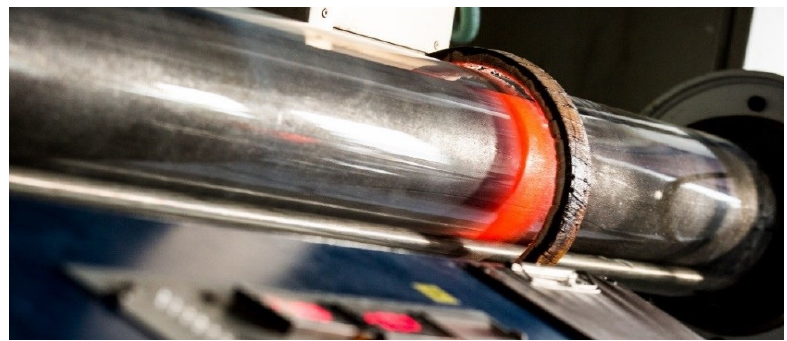
Figure 1. Horizontal zone refining equipment with a single induction heater (photo by Martin Braun).